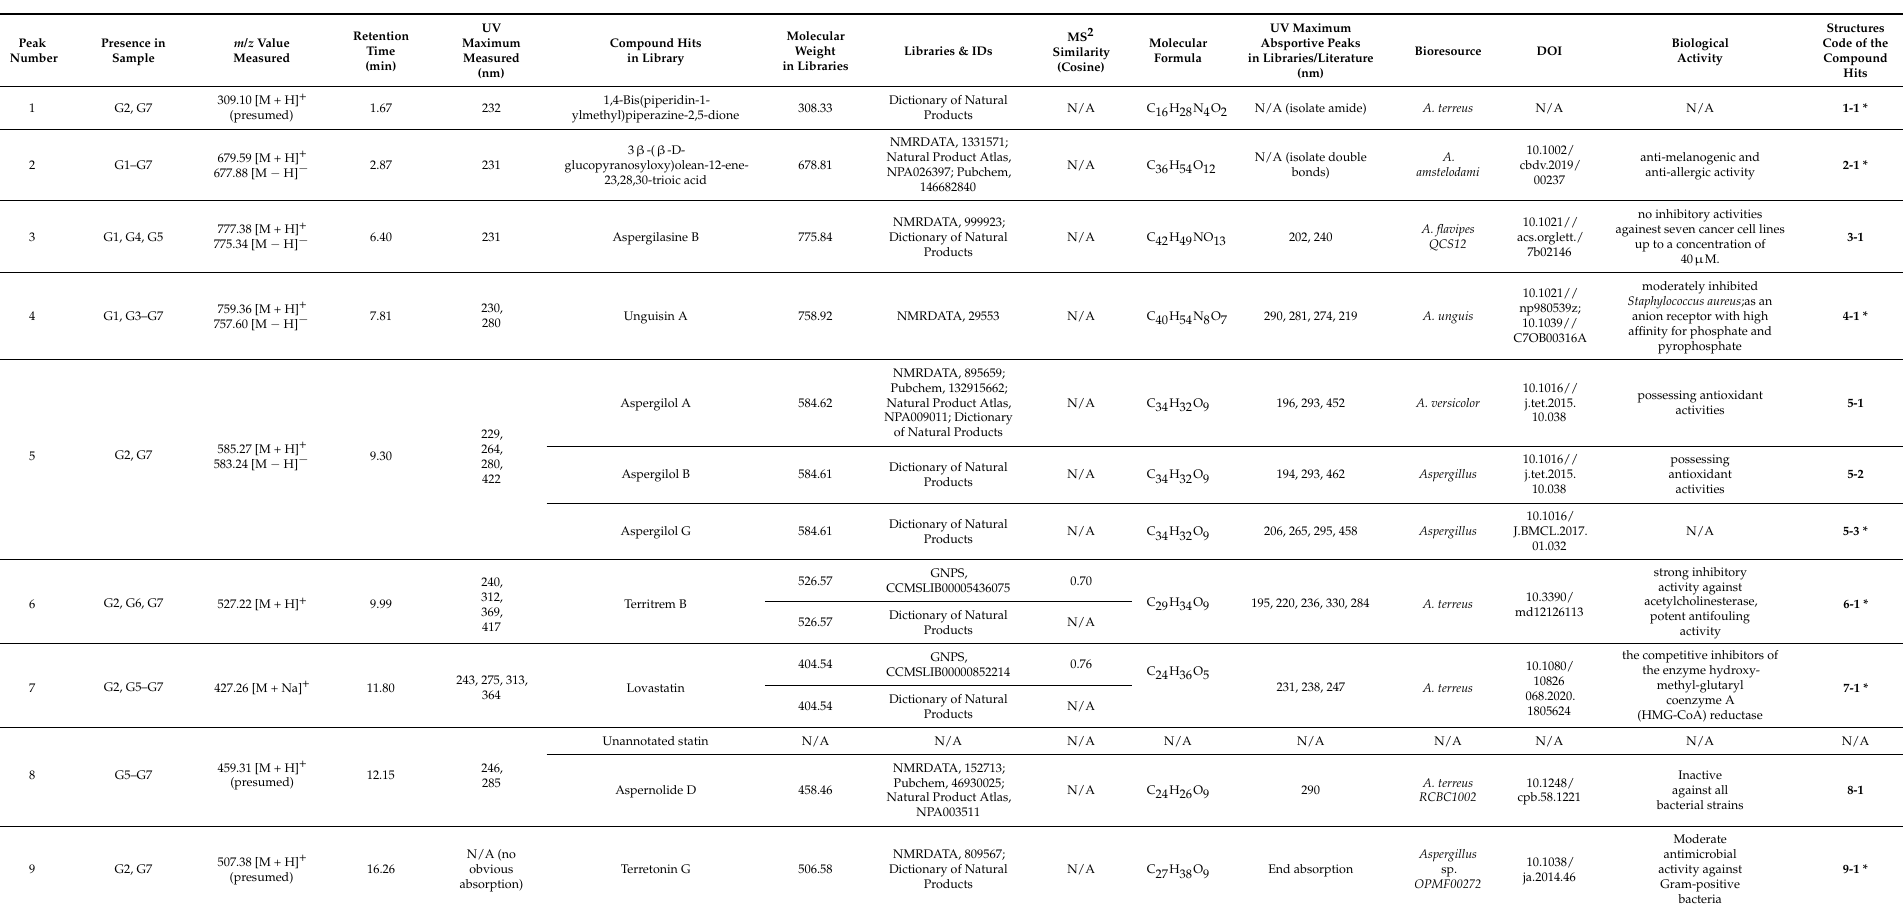
Table 3. Multiple database mining of the main peaks that show remarkably different yields in base peak chromatographies (BPCs) of their LC-MS profiles using positive and negative modes of